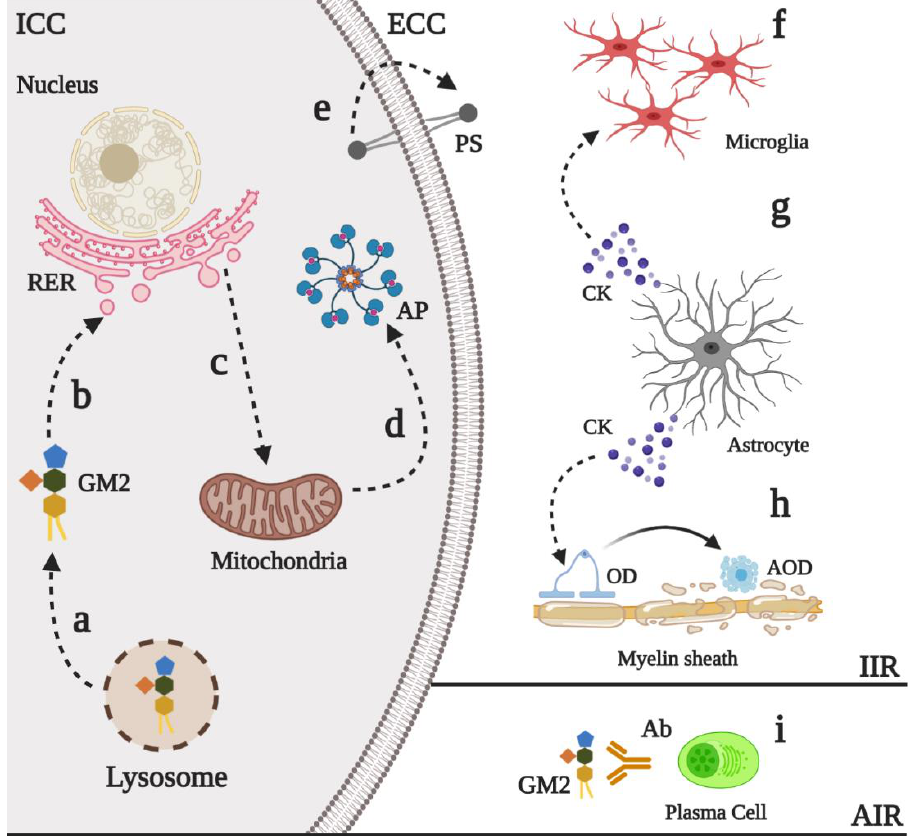
Figure 4. Physiopathological events in GM2 gangliosidoses. Innate (IIR) and adaptative (AIR) immune response have been described in GM2 gangliosidoses. Upon the impaired of lysosomal degradation of the GM2 ganglioside, this can be released into the cytoplasm ( a ) where its sialic acid can interact with the rough endoplasmic reticulum (RER) ( b ). Sustained stress into RER induces the activation of proapoptotic proteins such as CHOP ( c ) that promotes mitochondrial-mediated apoptosis ( d ) In early apoptosis states, the phosphatidylserine (PS) is externalized ( e ), which promotes the recruitment of several proinflammatory cells such as microglia ( f ). Astrogliosis has also been reported in the GM2 gangliosidoses ( g ). The release of several astrocyte-derived cytokines (CK), such as CCL2 and CXCL10, increases the recruitment of microglia and the apoptosis in myelinating oligodendrocytes (AOD), which induces neuron demyelination ( h ). Finally, auto antibodies (Ab) against GM2 ganglioside seem to contribute to the physiopathology of the GM2 gangliosidoses ( i ), although the precise mechanism of its release has not described. ECC: Extracellular compartment, ICC: Intracellular compartment, AP: Apoptosome, OD: Oligodendrocyte.